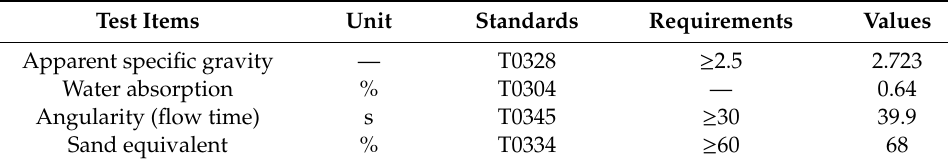
Table 3. Technical properties of basalt fine